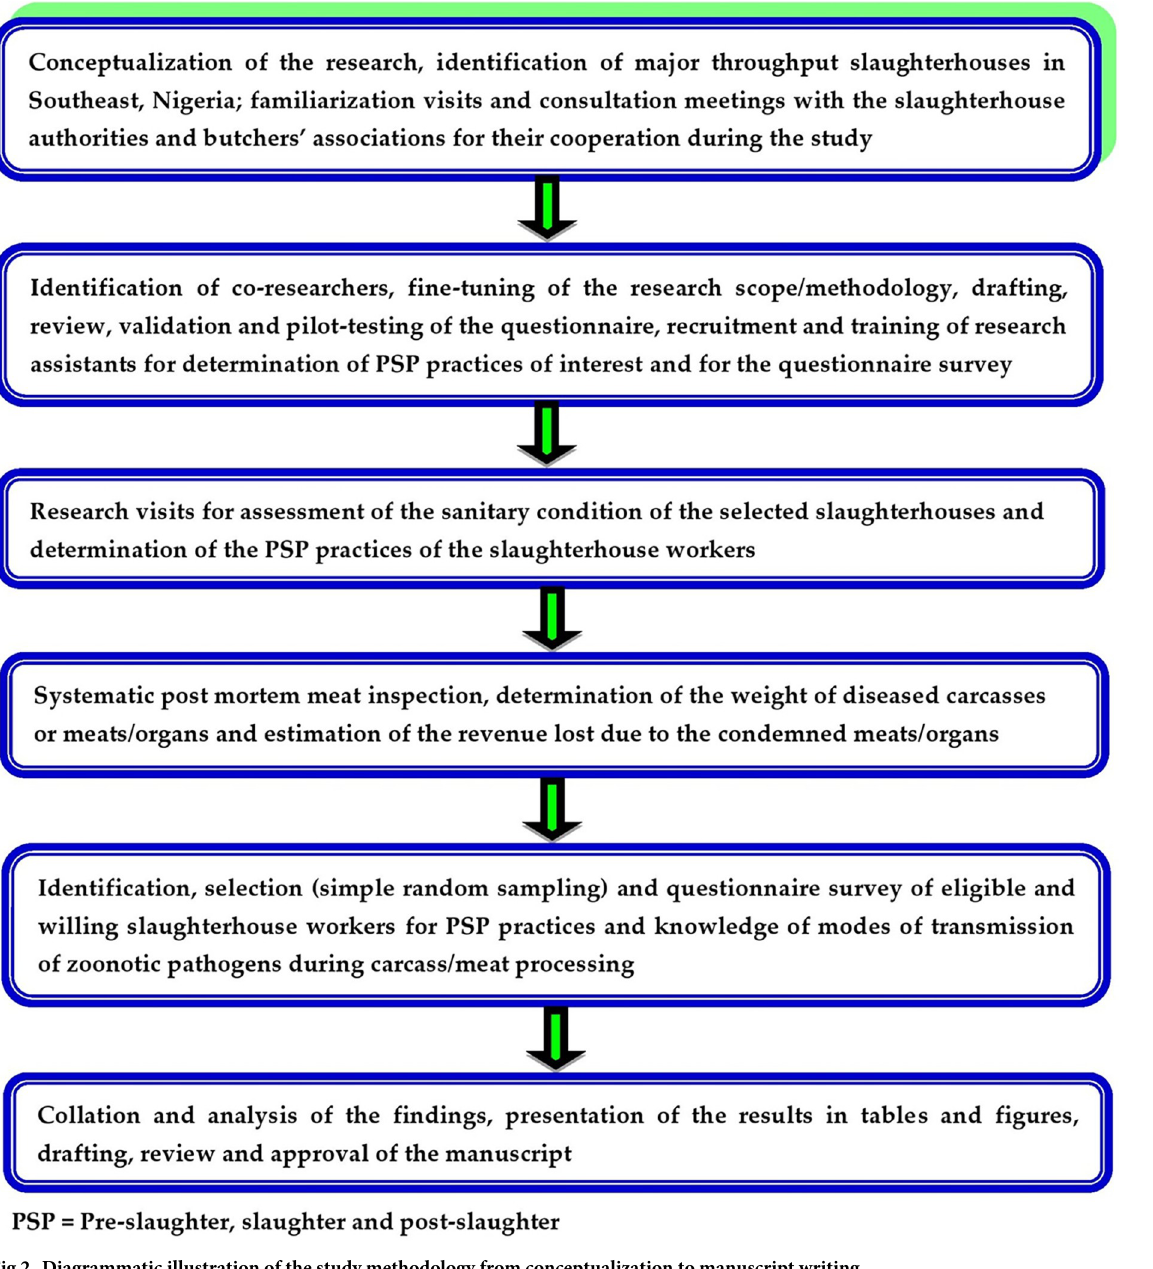
Fig 2. Diagrammatic illustration of the study methodology from conceptualization to manuscript